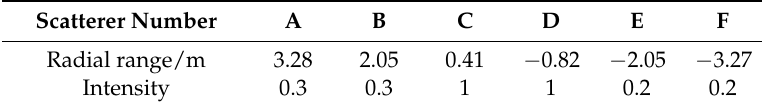
Table 2. Relative radial range and intensity for the scatterers.